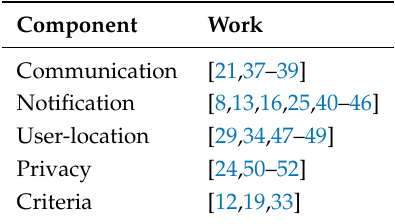
Table 2. Works used to define the components of the